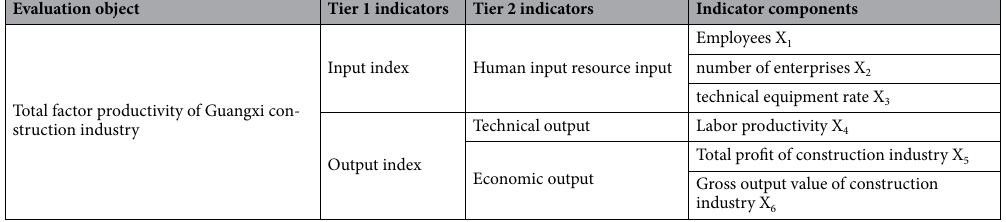
Table 1. Total factor productivity index system of Guangxi construction